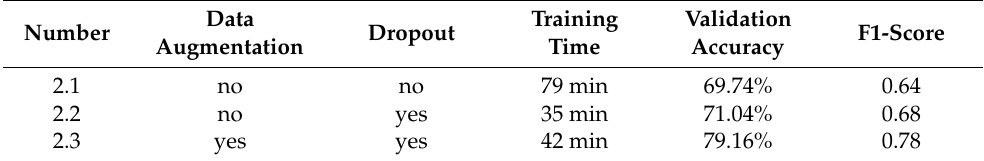
Table 5. Evaluation table for the second